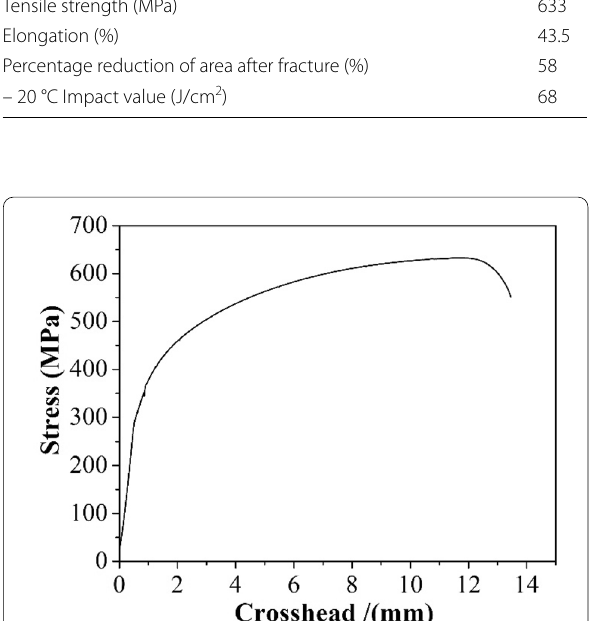
Figure 10 Tensile curve of the CuMn 13 Al 7 sample made by wire arc additive